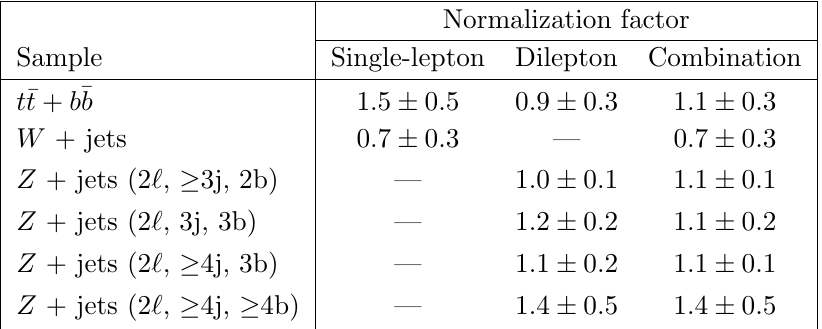
Table 3. Normalization factors included as independent free-(cid:13)oating factors in the likelihood (cid:12)t. The uncertainties include statistical and systematic components.